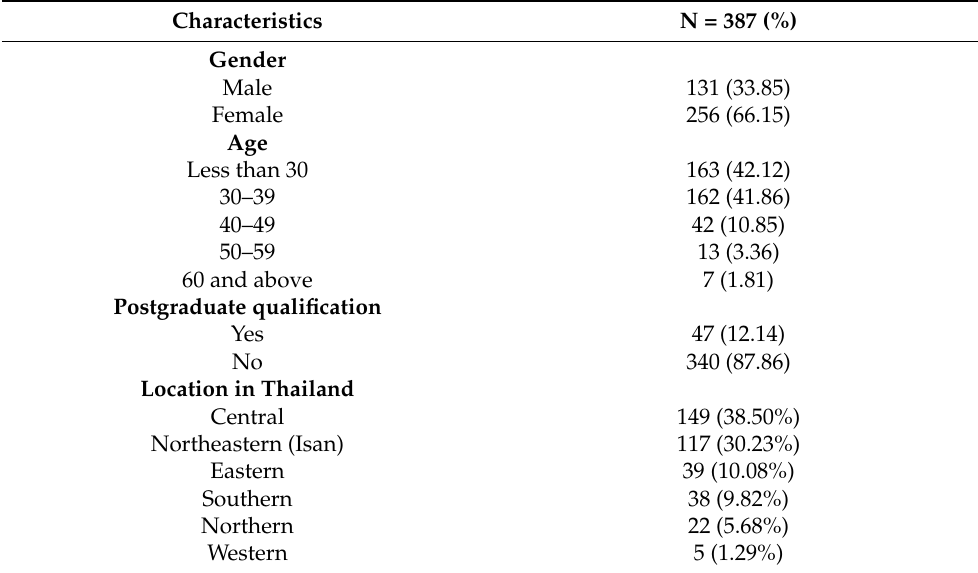
Table 1. Socio-demographic characteristics of